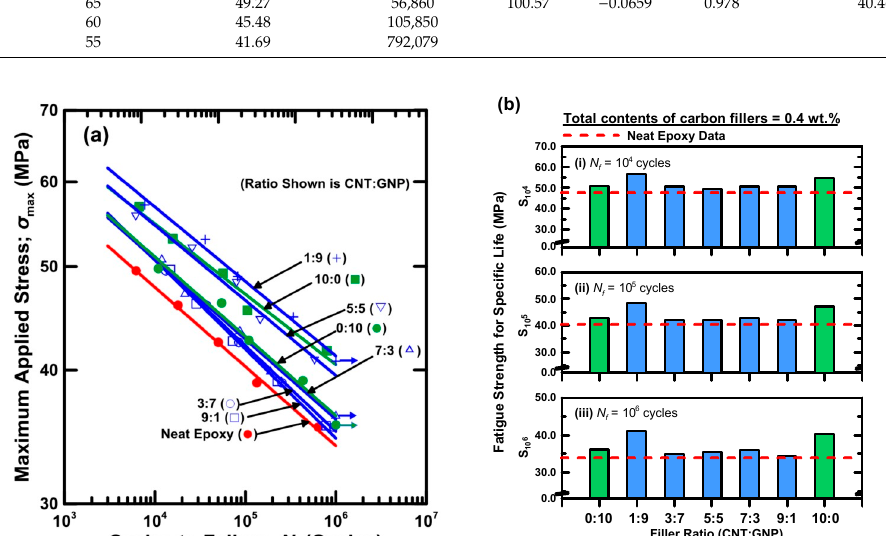
Figure 8. ( a ) S-N curves for the nanocomposites with various filler ratios, and ( b ) variations of fatigue strengths corresponding to various fatigue lives with filler ratios.